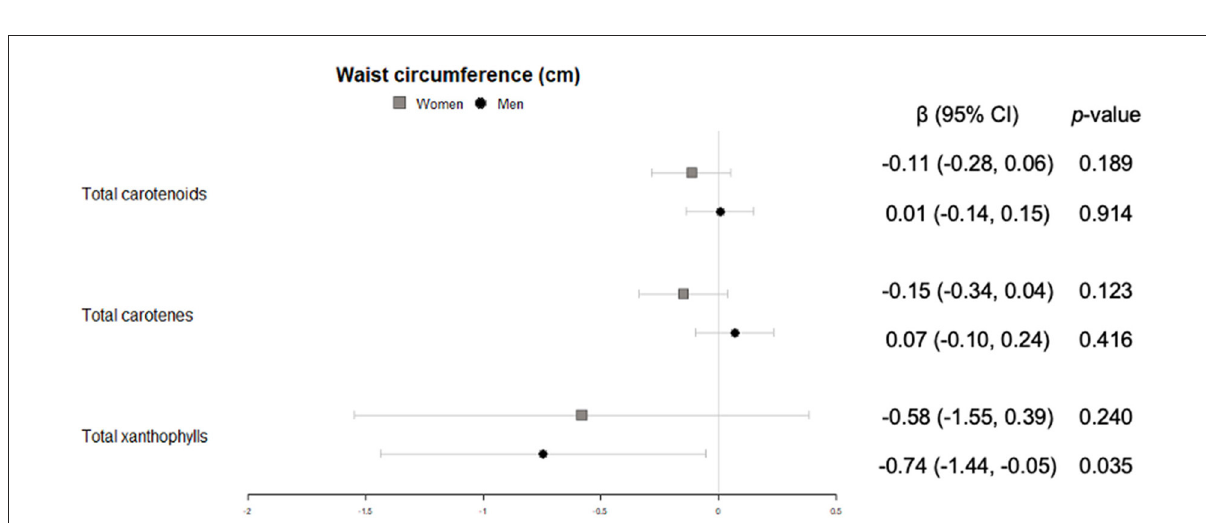
FIGURE2 Cross-sectional association of plasma carotenoids and subclasses (per unit increase) with waist circumference (cm) (95%-CI), and their respective p -values.